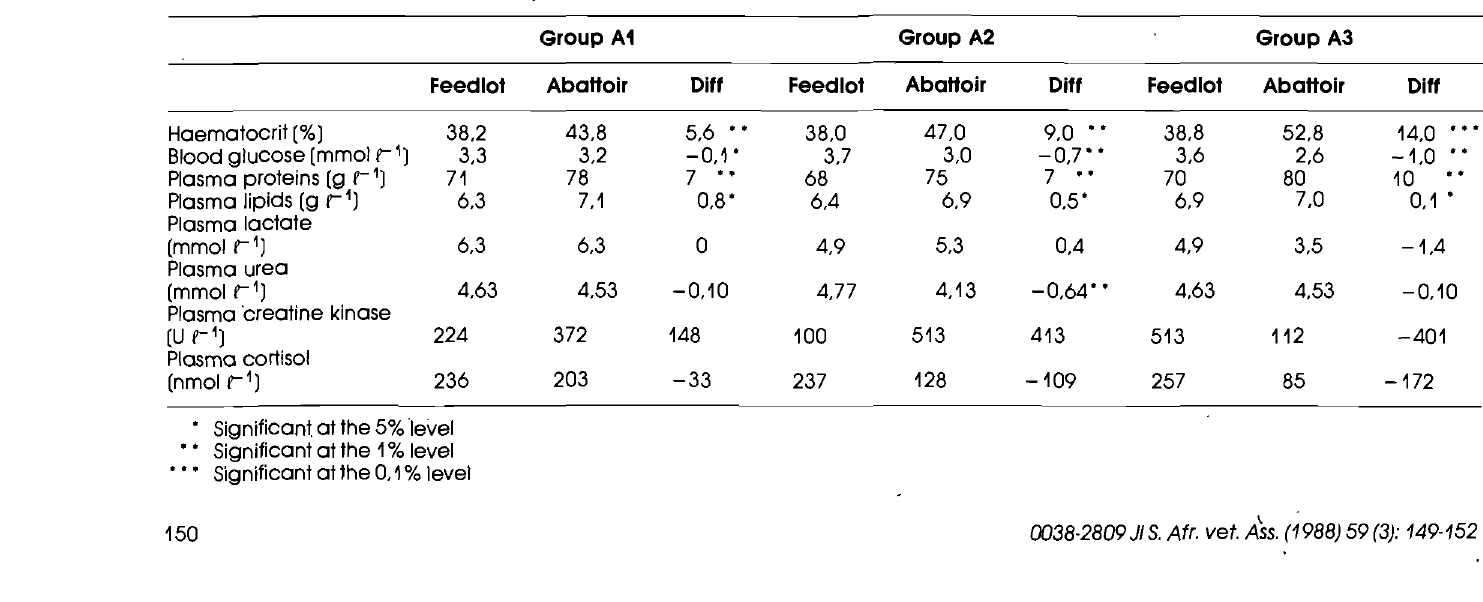
Table 1: The mean values obtained from the analyses of blood samples collected both at the feedlot and prior to slaughter and the differences between them (trial